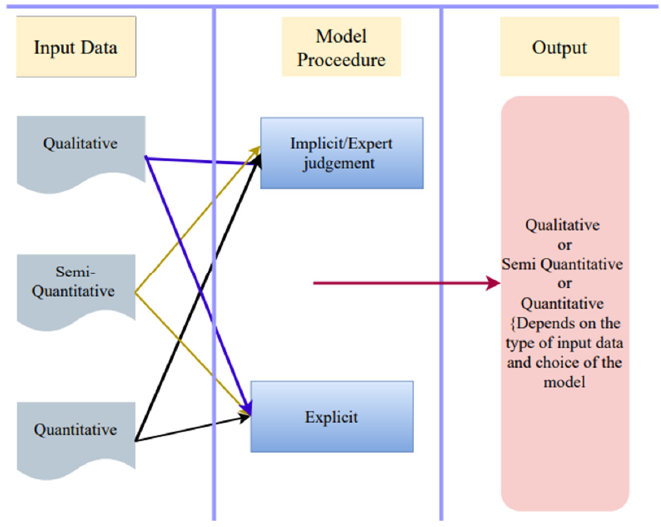
Figure 9. Process stage of uncertainties associated with vulnerability analysis [88].